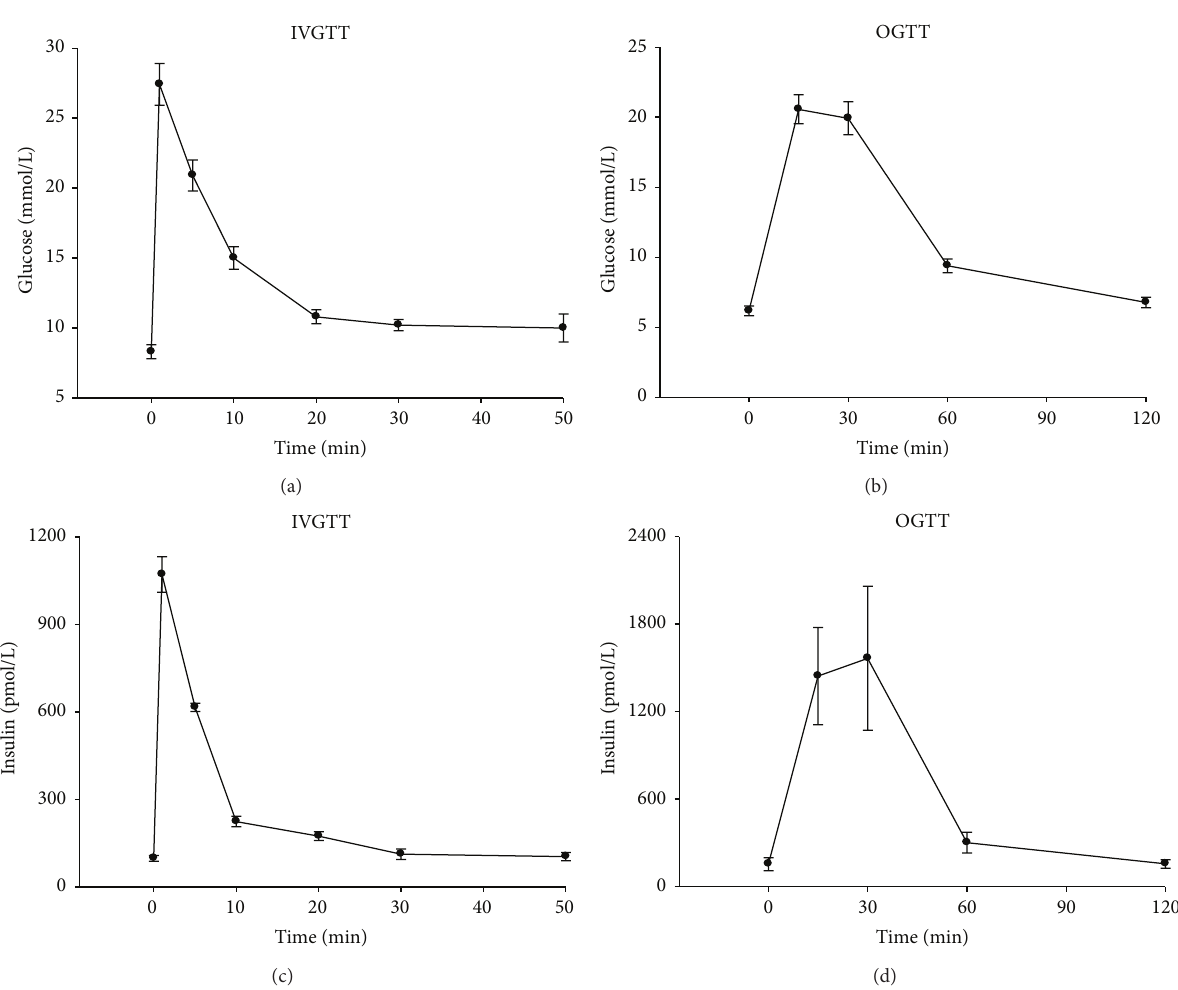
Figure 2: Example of outcomes from metabolic tests. Glucose and insulin levels (means ± sem) after intravenous (1g/kg; 𝑛 = 18 ) or oral (75mg; 𝑛 = 27 ) glucose administration in normal C57/BL6